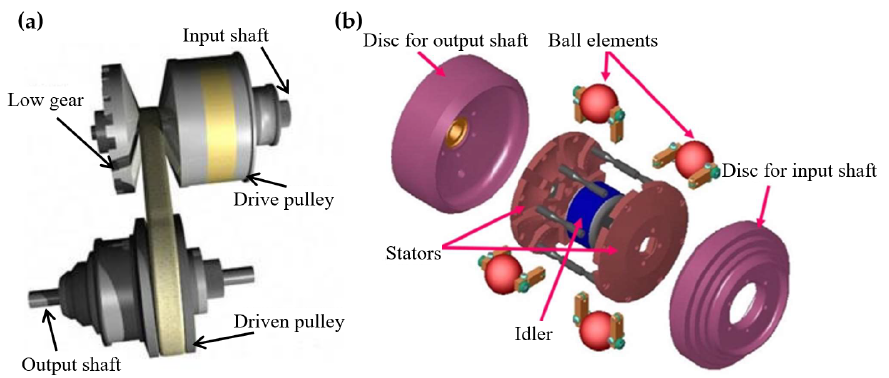
Figure 6. Schematic of CVTs [93]: ( a ) a belt/chain-pully-based CVT and ( b ) a ball-actuated